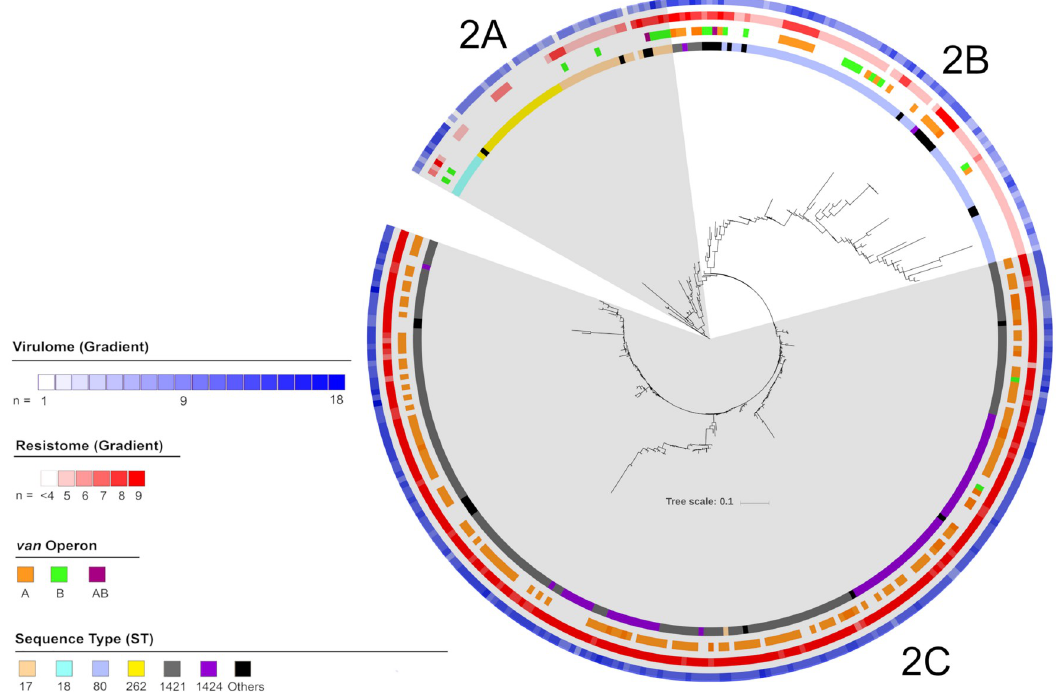
Fig 3. Maximum likelihood phylogenetic tree of cluster 2 isolates. From the outermost ring: Number of virulence factors, number of resistance genes not including the van operon, type of van operon and sequence types are highlighted as per legend.